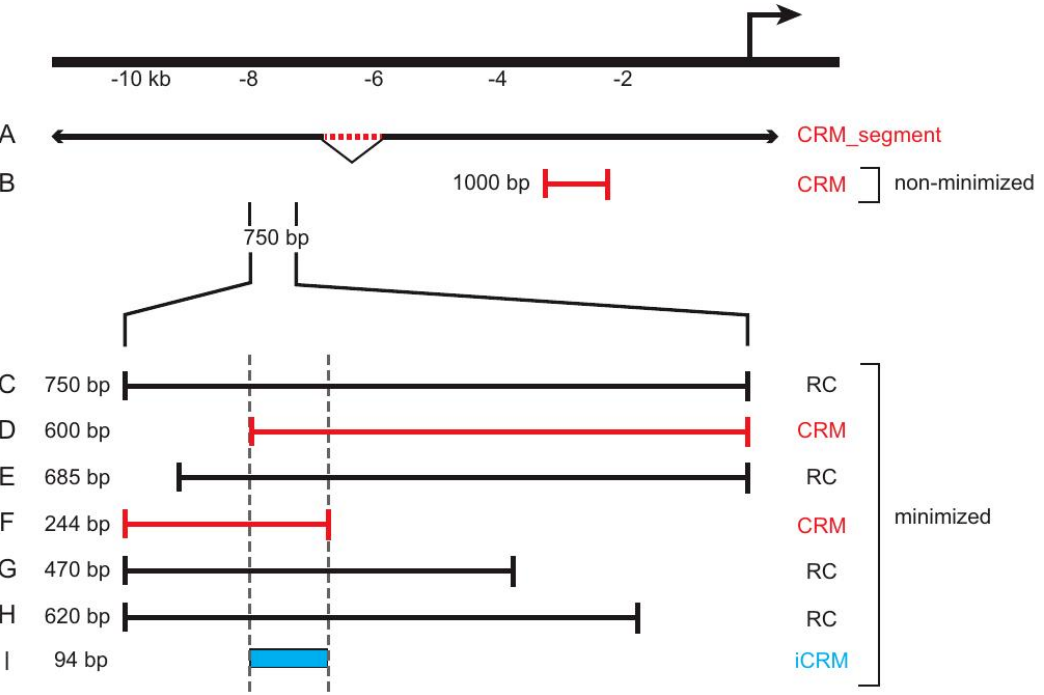
Figure 3. REDfly data subclasses and Reporter Construct attributes. The figure illustrates a hypothet- ical locus for which different sequences have been tested in vivo. Sequence ( A ) represents an ap- proximately 1 kb genomic deletion (red dotted line) that reduces expression from the nearby pro- moter 6 kb downstream (bent arrow). As such, it is considered a CRM_segment . Sequence ( B ) is a 1 kb sequence fragment located roughly 2 kb upstream of the transcription start. Since it is an isolated sequence, it is considered to be a CRM that has not been subject to minimization. If this construct showed reporter gene activity, it would be designated as “expression positive”; otherwise, it would be labeled “expression negative.” Constructs ( C – H ) are part of an overlapping and partially nested series of sequences spanning 750 bp of DNA 7.25 kb upstream of the transcription start. In this example, each drives the identical pattern of reporter gene expression. Since each of these sequences overlaps at least one other, we consider this region and the six sequences to have undergone minimization. Sequences ( D , F ) are each the shortest of a respective set of fully nested sequences and are, therefore, considered to be CRMs (marked in red). The remaining sequences are designated as RCs (black). A 94 bp sequence, ( I ), marks the minimal region of overlap among all of the sequences and is, thus, registered in REDfly as an inferred CRM ( iCRM ,